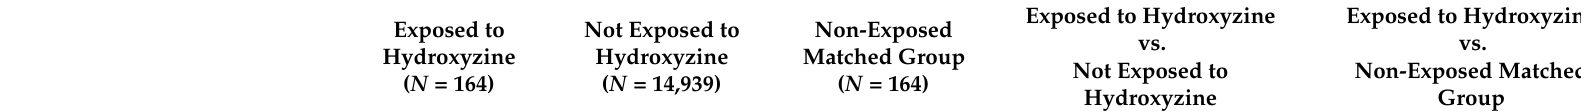
Table 1. Characteristics of inpatients with COVID-19 receiving or not receiving